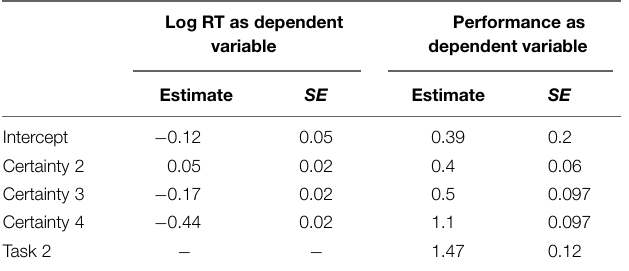
TABLE 1 | Minimum adequate model for RT and performance as dependent variable.